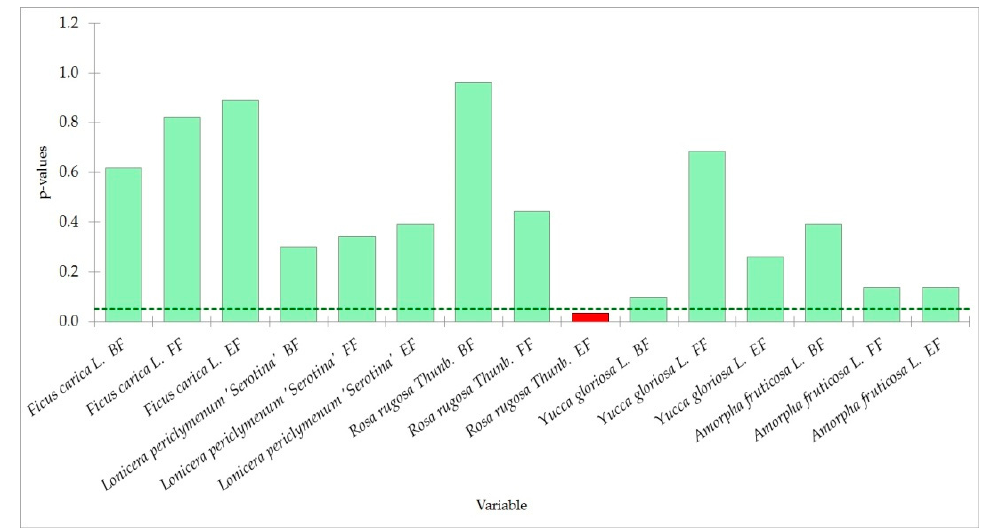
Figure 3. Graphical representation of p -value and Sen’s slope for temperature sums (°C) for the beginning of flowering (BF), full flowering (FF), and the end of flowering (EF) for 13 woody taxa in the period 2007–2022 for Belgrade (top) and Sur č in (bottom).